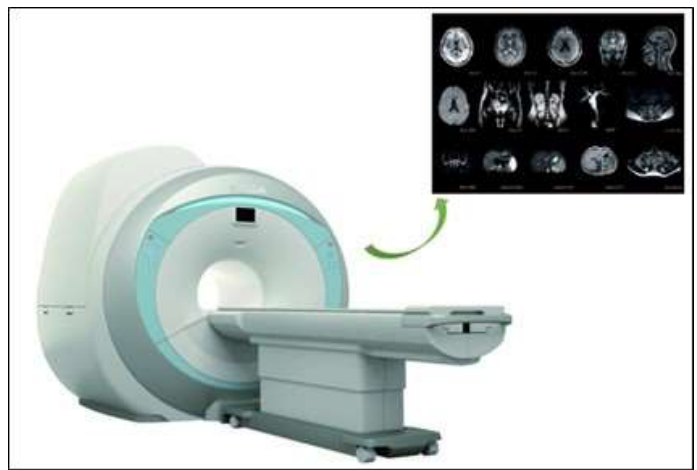
Figure 10: MRI device for medical applications.